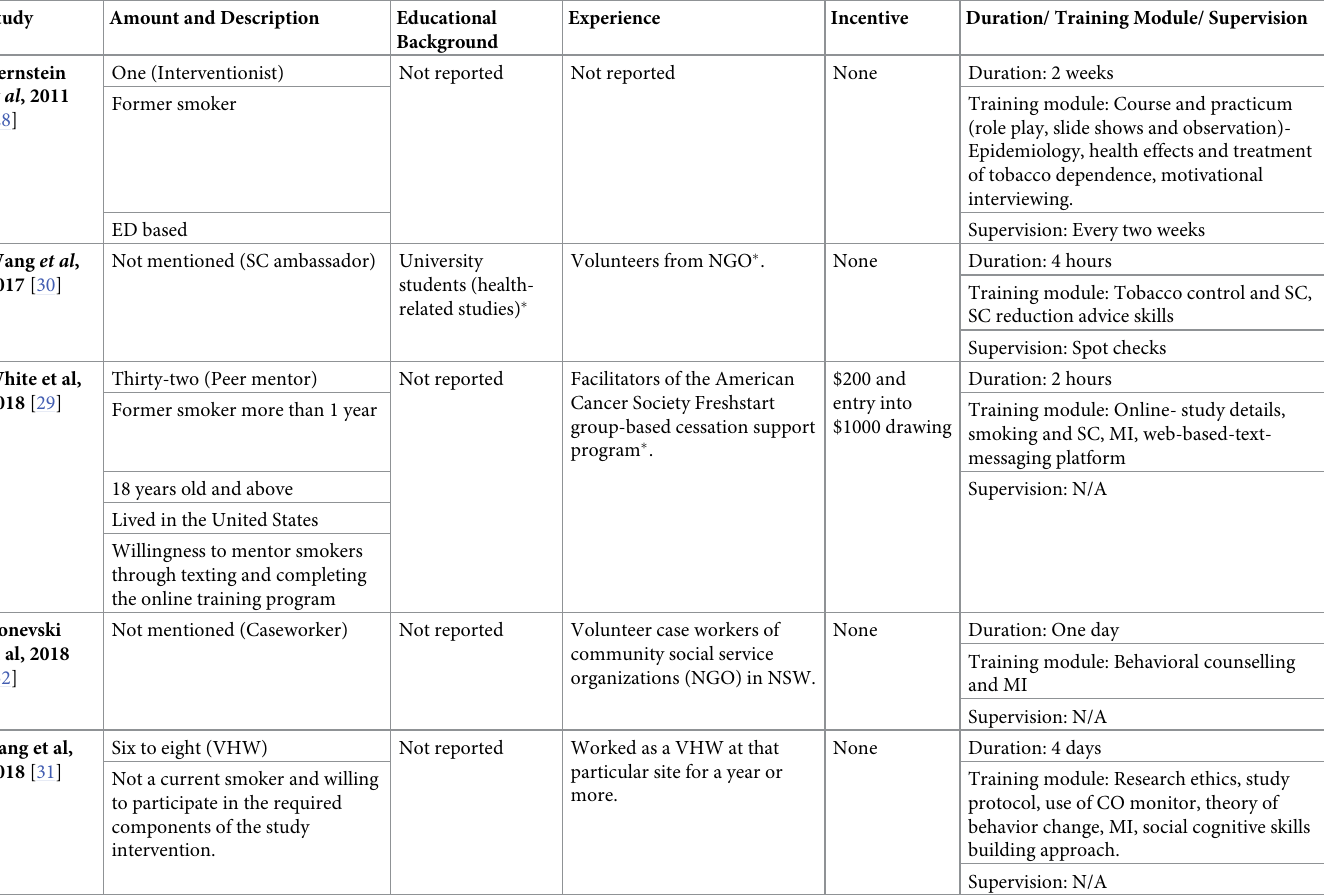
Table 3. Characteristic of community health worker and training of community health